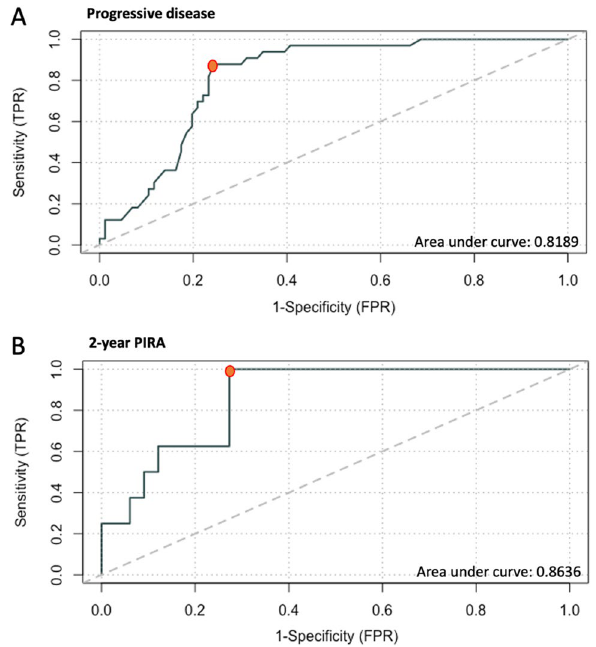
Figure 3. Receiver operating characteristics (ROC) curve analysis to obtain global MFIS cut-off values for prediction of progressive disease. ( A ) ROC curve to calculate a cut-off value by comparing global MFIS score between pwPMS and pwRMS cohorts ( B ) ROC curve to calculate a cut-off value by comparing global MFIS score between patients with and/or without PIRA in the pwRMS cohort. Abbreviations: pwPMS: person with progressive MS; pwRMS: person with relapsing MS; MFIS: Modified Fatigue Impact Scale;PIRA: progression- independent of relapse